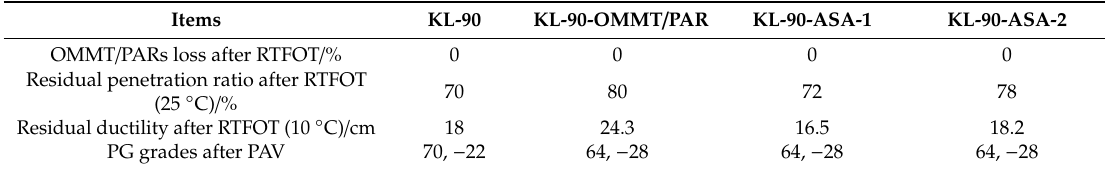
Table 12. Aging indices of asphalts with anti-stripping